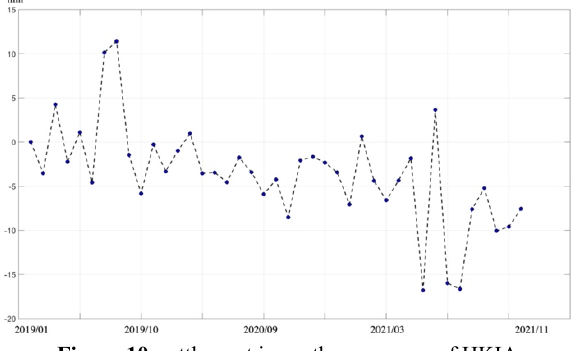
Figure 10 . settlement in southern runway of